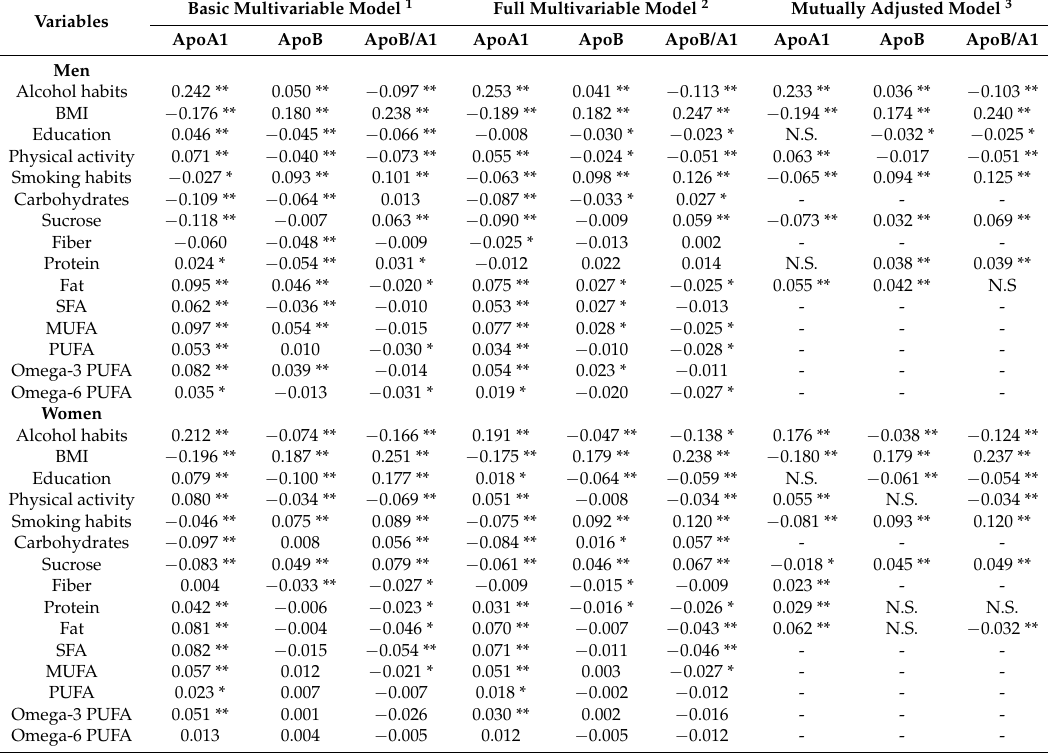
Table 2. Partial correlation between lifestyle and dietary factors and serum apolipoprotein concentrations among the 9363 men and 15,621 women enrolled in the Malmö Diet and Cancer cohort